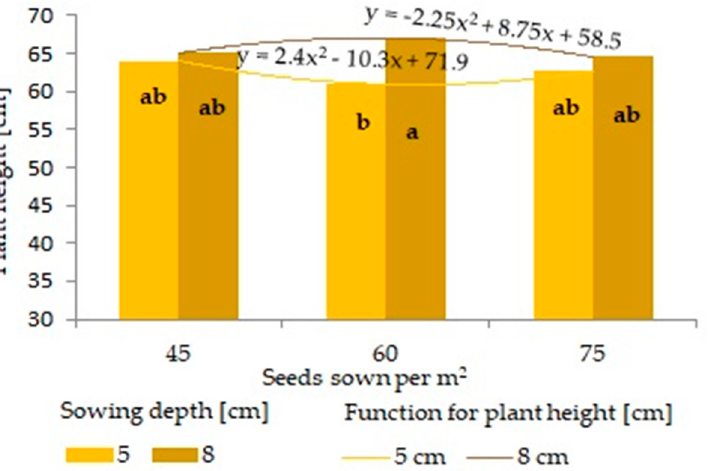
Figure 6. Plant height in 2011 (SDH × SDY). Different letters indicate significant differences between factors (Tukey’s multiple range test).